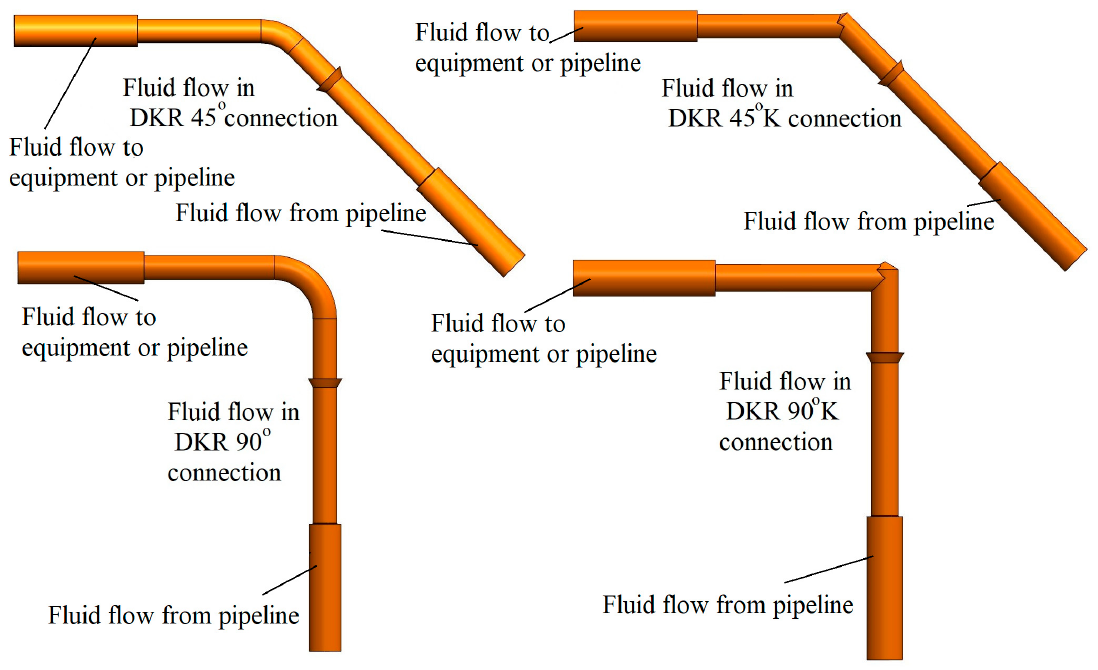
Figure 3. Model of fluid flow in the connections of angular fittings in pipelines.